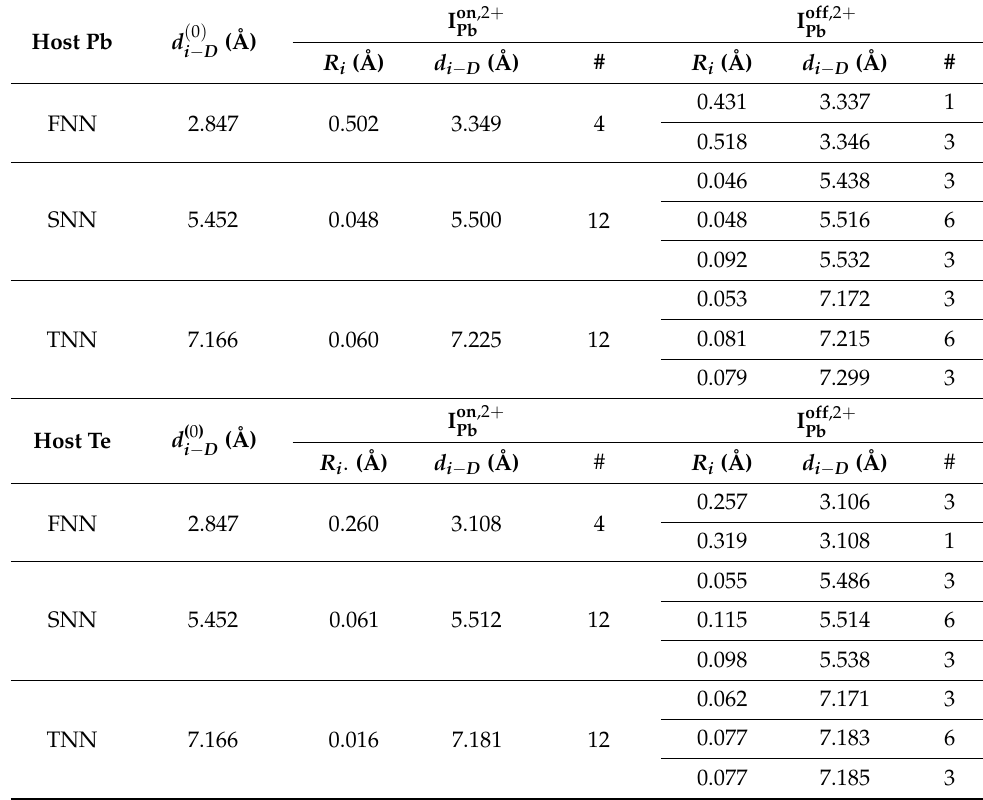
Table 1. Distributions of d (bottom part) atoms in the defective supercell with the on-centered (I on,2 + Pb interstitial defects, where d third-nearest neighbors,